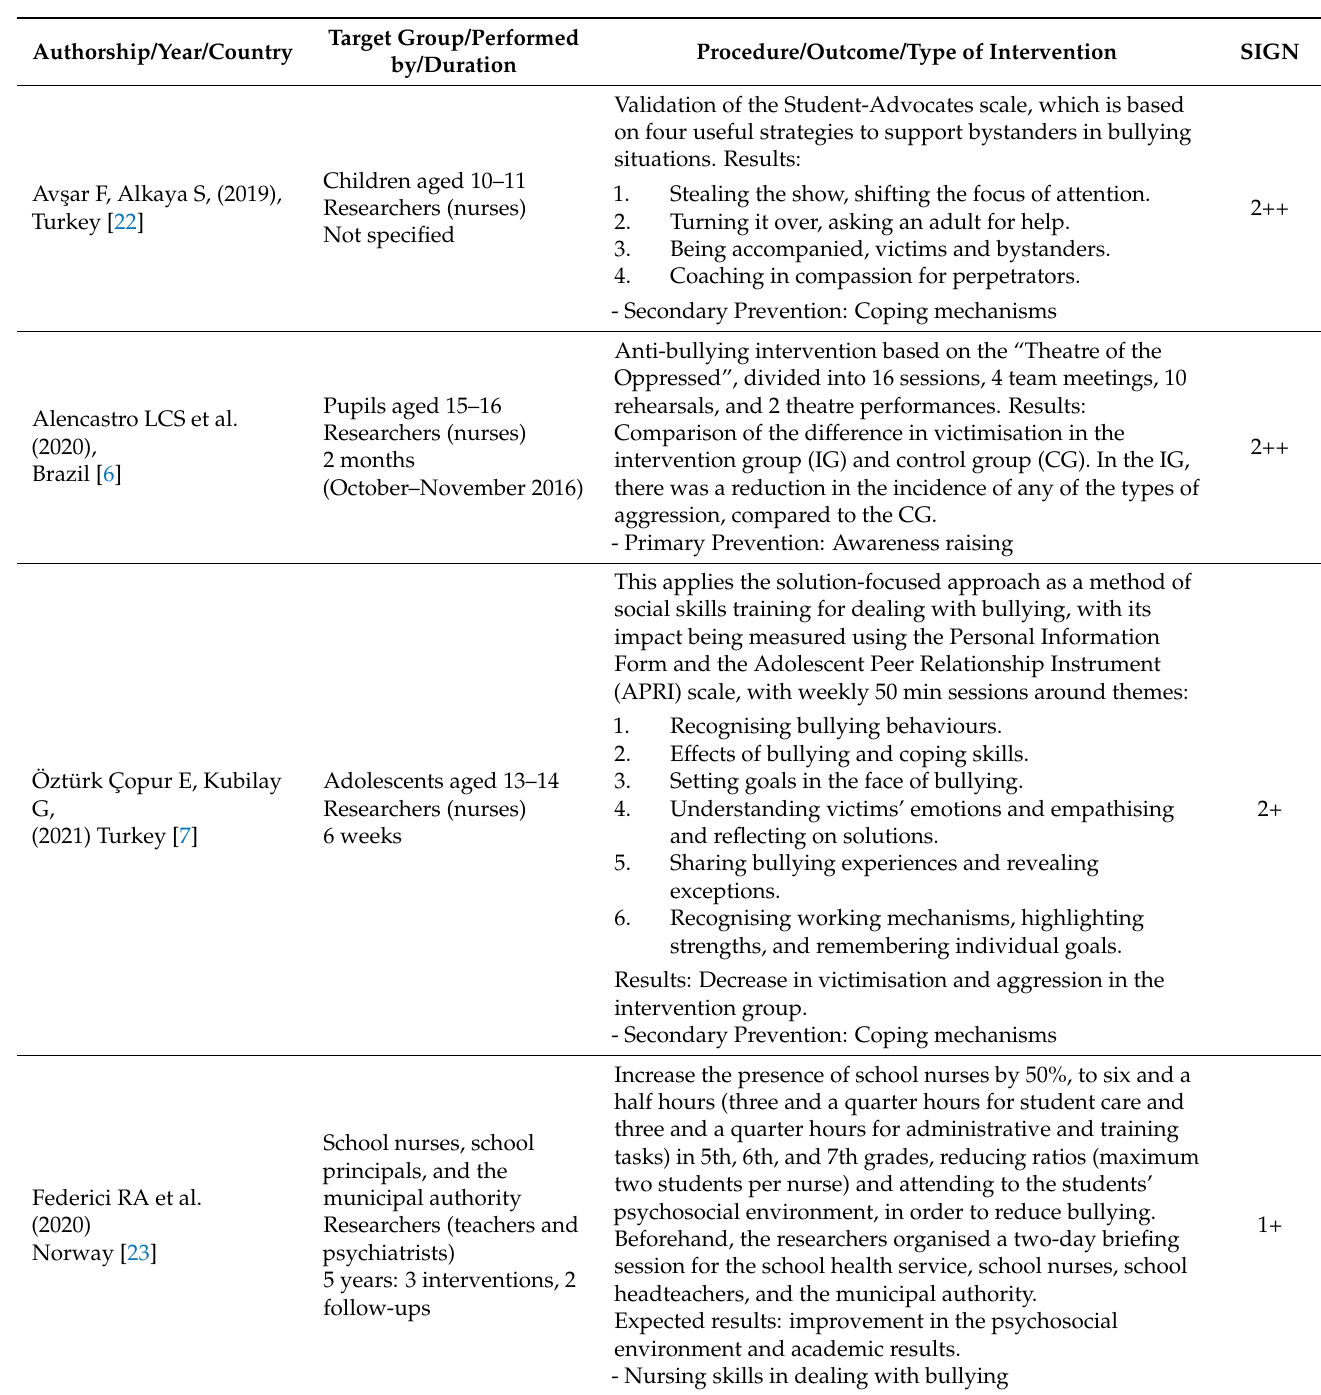
Table 2. Synthesis of interventions from quantitative and observational studies and Scottish Intercol- legiate Guidelines Network (SIGN) levels of